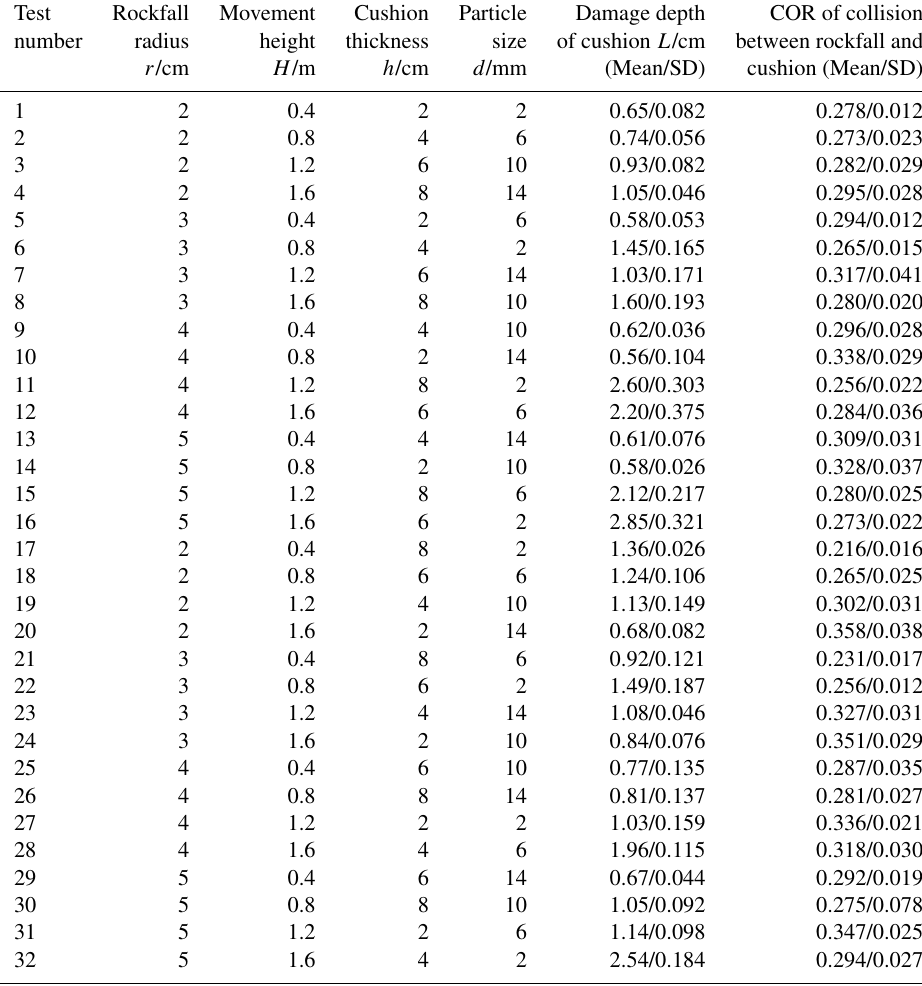
Table 5. Orthogonal test results.